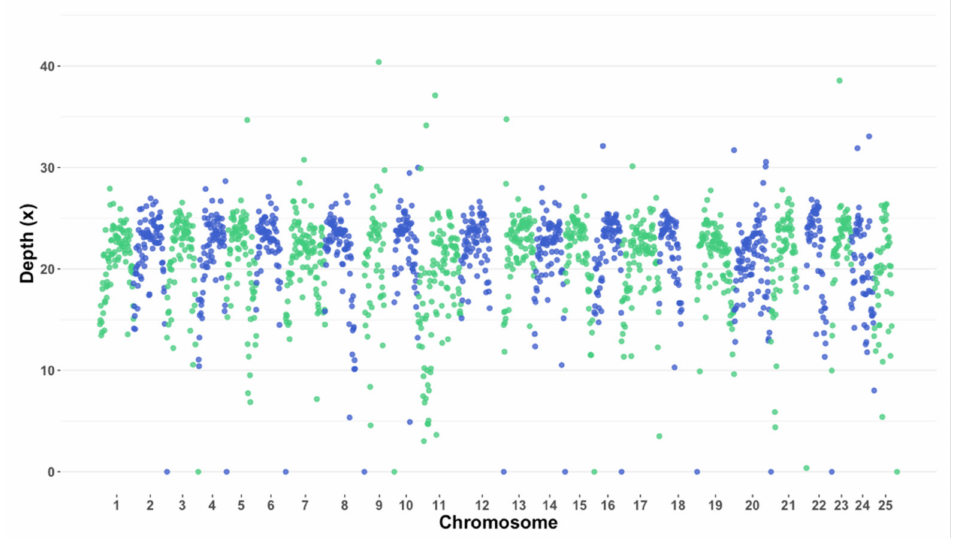
Figure 2. Average depth of coverage per megabase across all Iowa samples. Chromosomes vary in color for easy